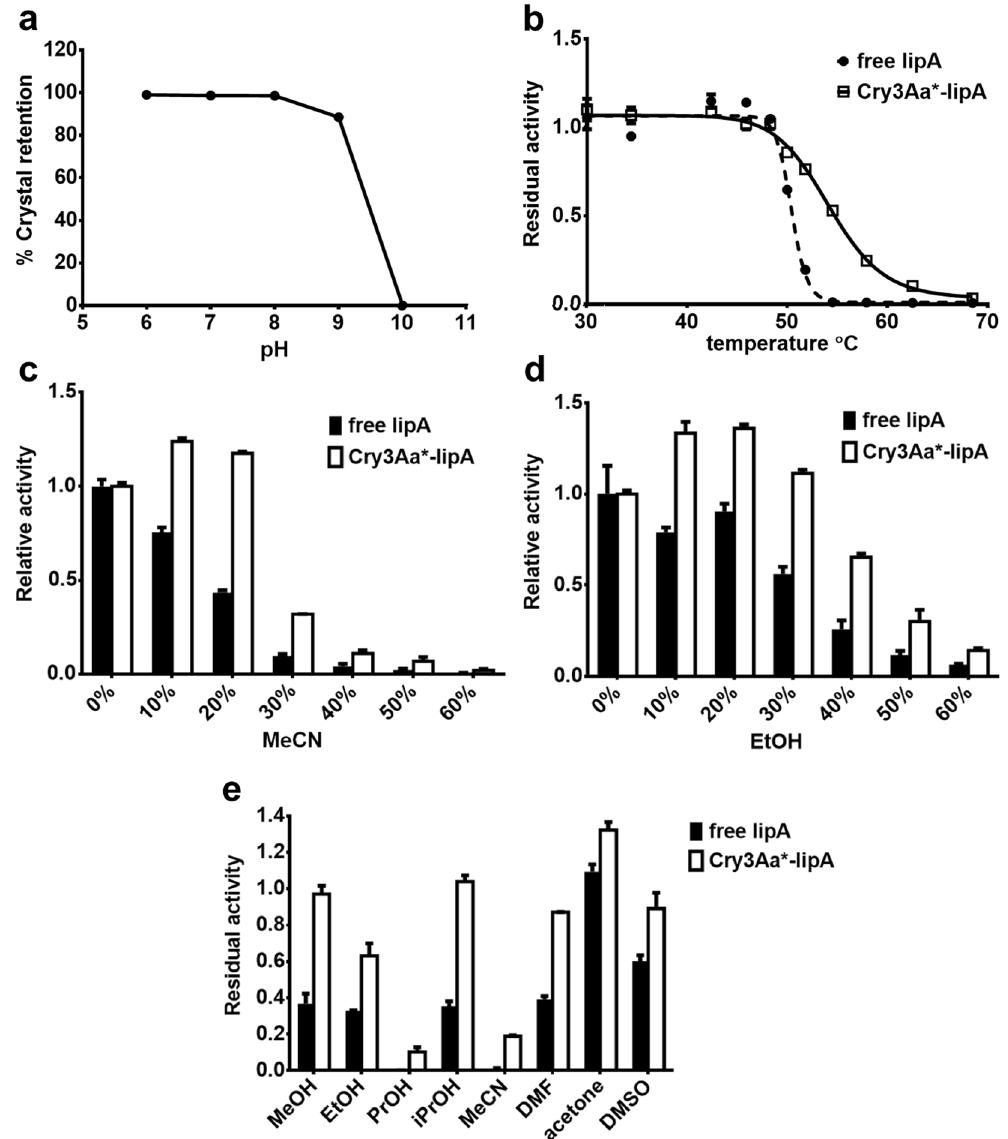
Figure 4. Stability of Cry3Aa * -lipA crystals. ( a ) Crystal retention of Cry3Aa * -lipA in various pH buffers at 2,000 rpm for 24 h. Values were normalized to the amount of protein solubilized at pH 10.0. ( b ) Thermal stability of free lipA and Cry3Aa * -lipA. Reactions were heated for 1 h at various temperatures prior to measuring residual activity, and then normalized to the residual activity at 30 °C. ( c ) Activity of free lipA and Cry3Aa * -lipA in increasing concentrations of MeCN and ( d ) EtOH. ( e ) 24 h stability of free lipA and Cry3Aa * - lipA in 50% v/v of MeOH, EtOH, PrOH, isopropyl alcohol (iPrOH), MeCN, dimethylformamide (DMF), acetone and dimethylsulfoxide (DMSO). All measurements were performed in triplicate. The error bars show the standard deviation of the mean. Error bars are present in Fig. 4a but the standard deviations are less than 1% so the error bars are difficult to